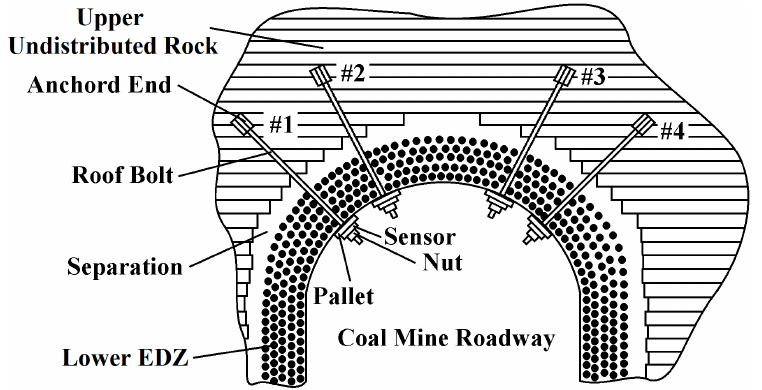
Figure 7. Monitoring schematic diagram of fiber Bragg grating stress sensors installed on the roof and sides of the